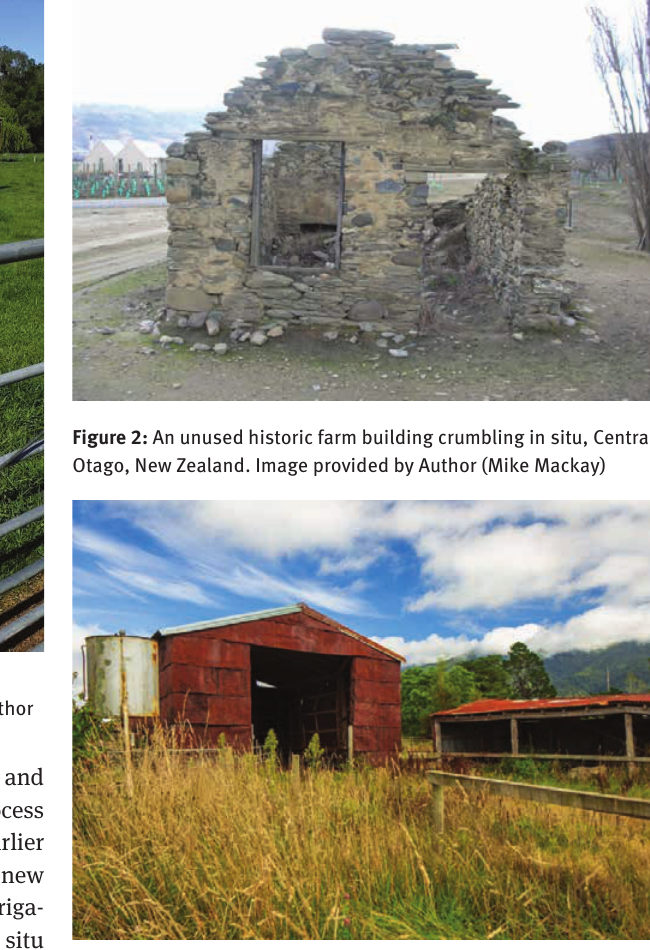
Figure 3: An iron farm barn rusting in situ, Collingwood, South Island, New Zealand. Image provided by James Gibson (under Crea- tive commons licensing